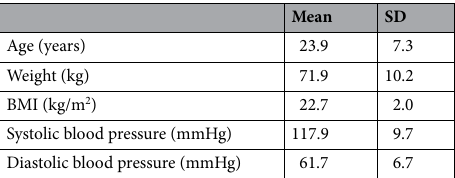
Table 1. Participant baseline characteristics (N =